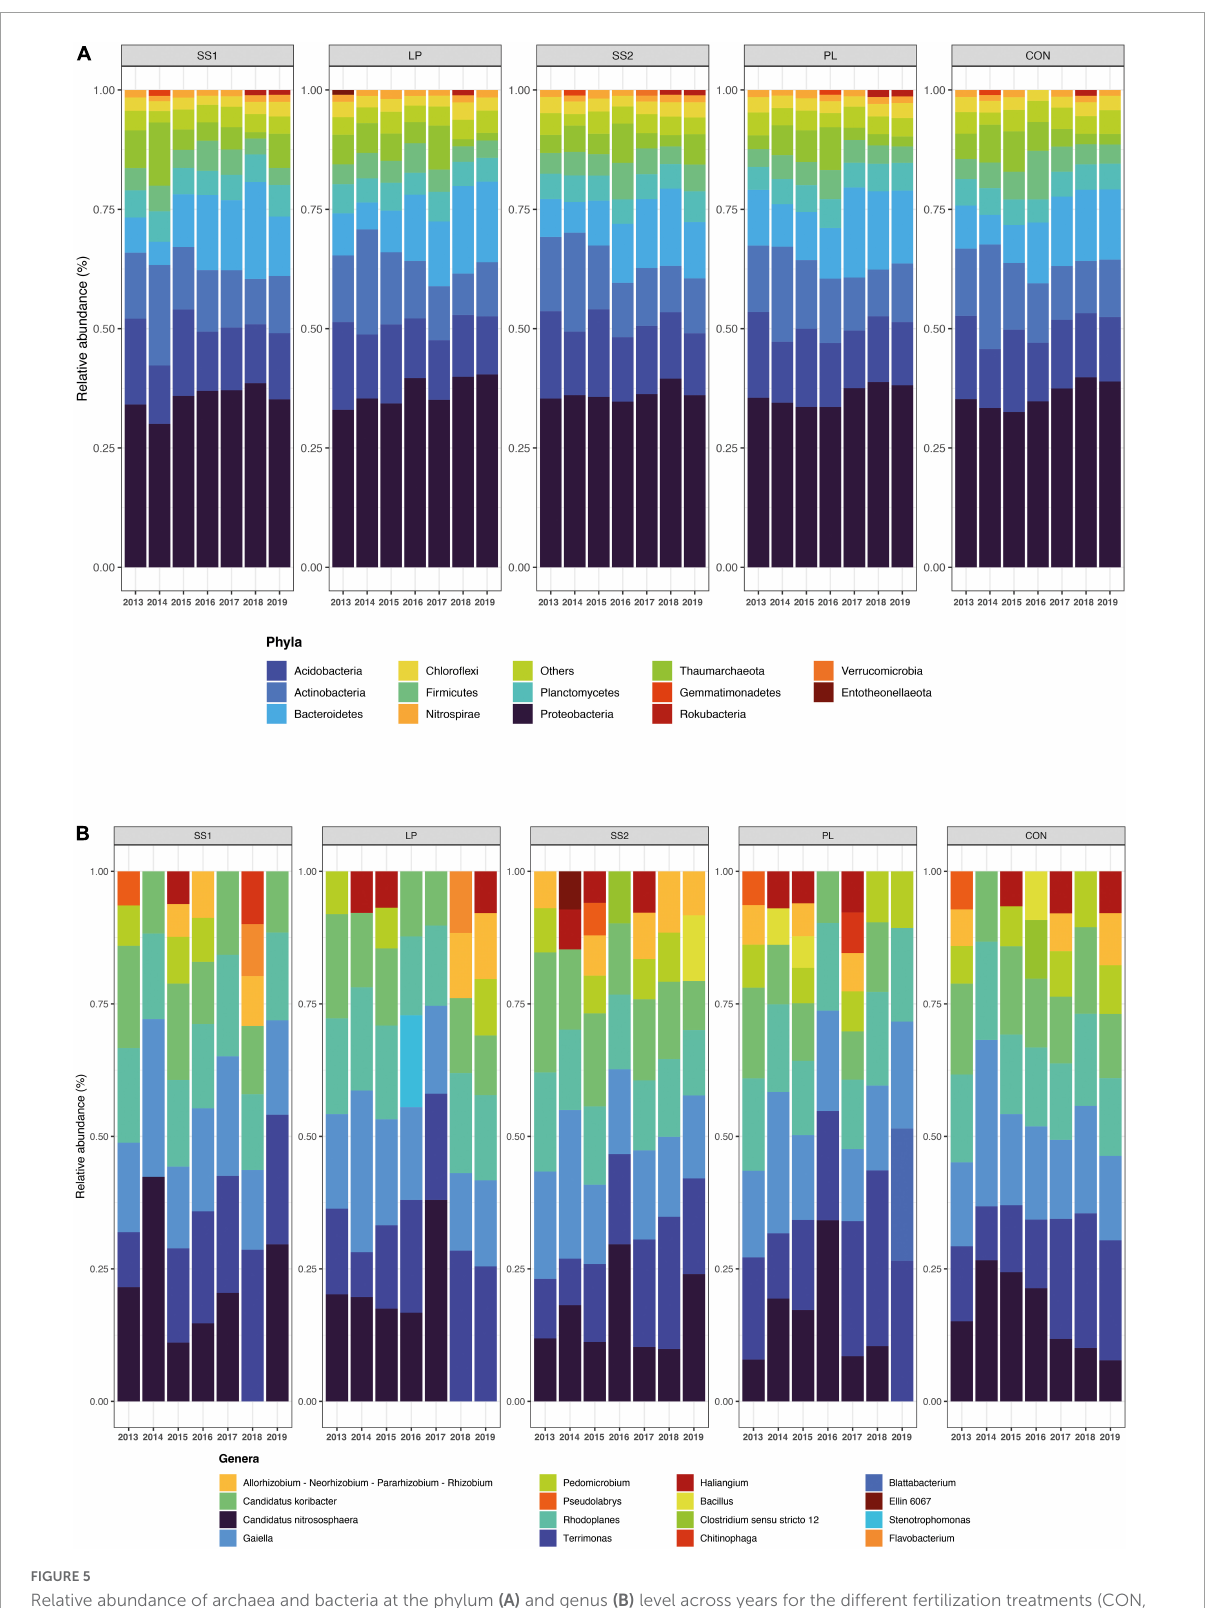
FIGURE5 Relative abundance of archaea and bacteria at the phylum (A) and genus (B) level across years for the different fertilization treatments (CON, inorganic fertilizer control) with four different organic materials (SS1 and SS2, sewage sludge inputs; LP, liquid pig manure; PL, poultry litter). Relative taxonomic abundances below 1 or 2% were grouped in “Others” for the phylum and genus levels, respectively. Unknown taxa were excluded from genus